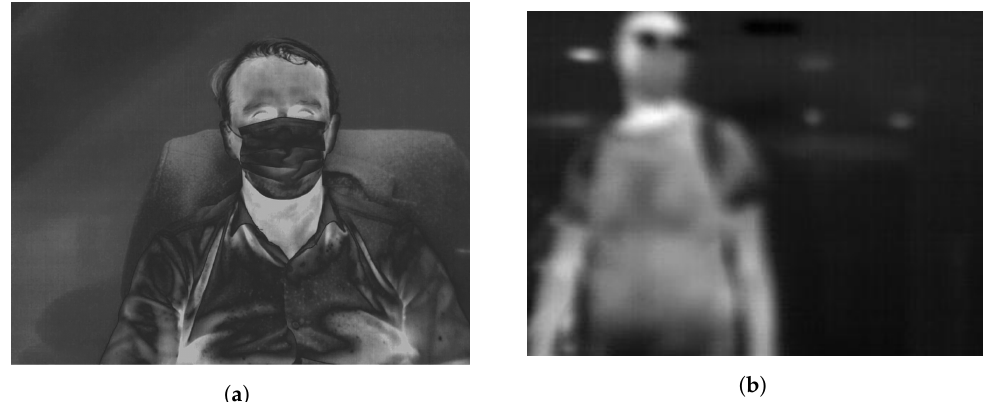
Figure 1. Examples of two types of images included in dataset: ( a ) good quality image and ( b ) poor quality